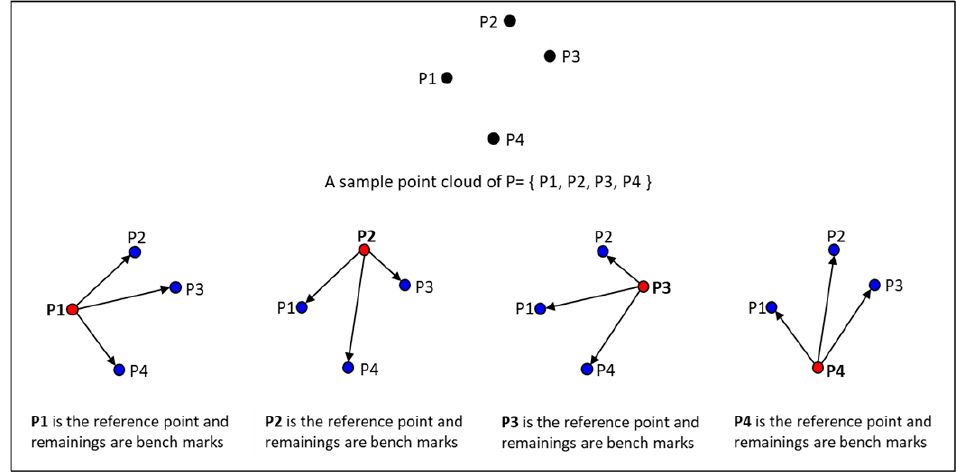
Figure 9. Cosine similarity combination